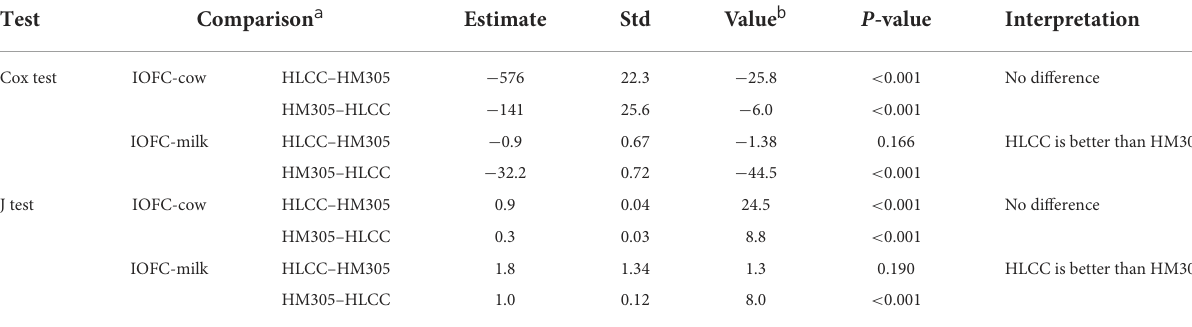
TABLE 6 Results of non-nested hypothesis testing from Cox test and J